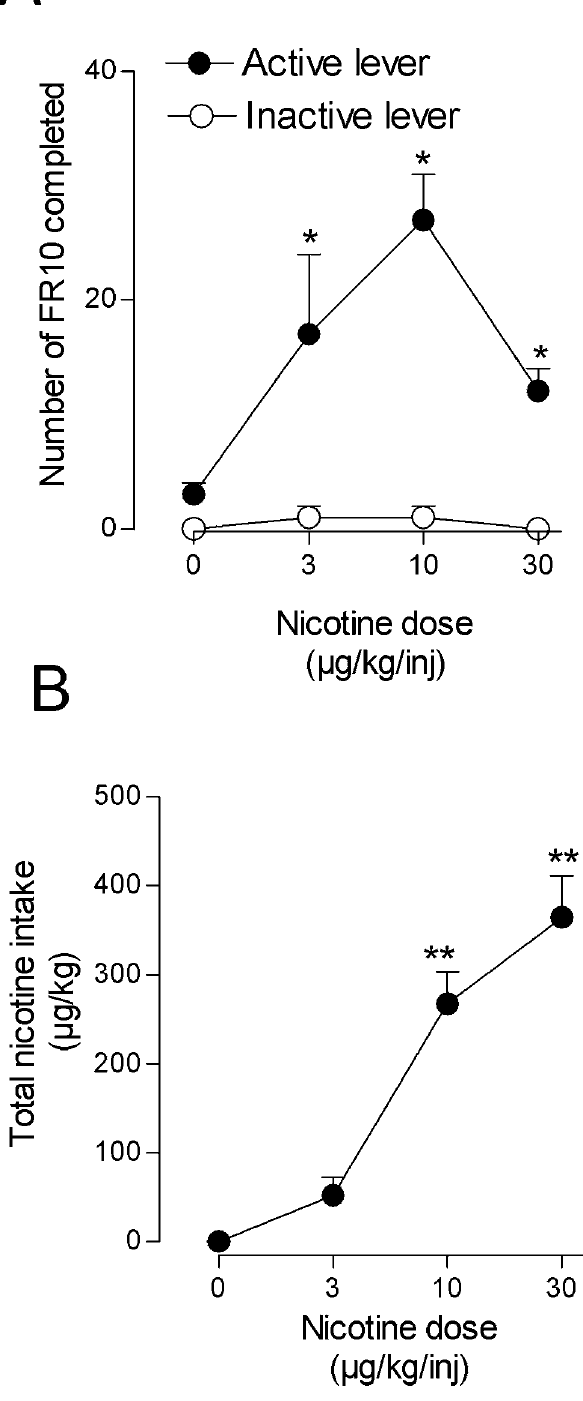
Figure 4 Influence of nicotine dose on nicotine self-administration and total nicotine intake per session under the FR 10 schedule. Number of fixed ratios completed on the active and inactive levers per session ( A ) and total nicotine intake per session ( B ) are presented as a function of injection dose of nicotine (n=5). Each symbol represents the mean ( 6 SEM) of at least three sessions under each nicotine injection dose condition * P , 0.05, ** P , 0.01 post-hoc comparisons with the saline vehicle (0 m g/kg per injection) conditions.